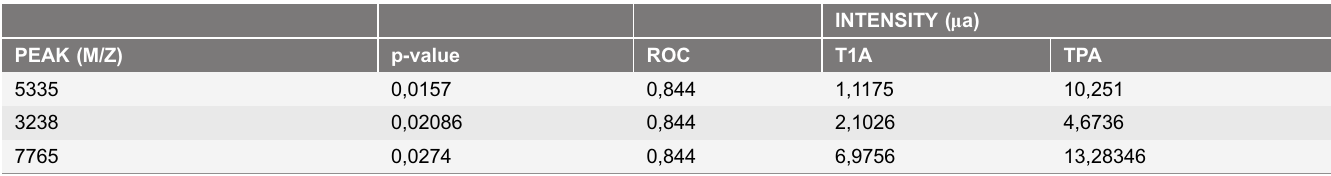
Table 4. Differential expression among vemurafenib treated patients; in all patients who progressed 3 peptides resulted significantly up-regulated compared to basal time.